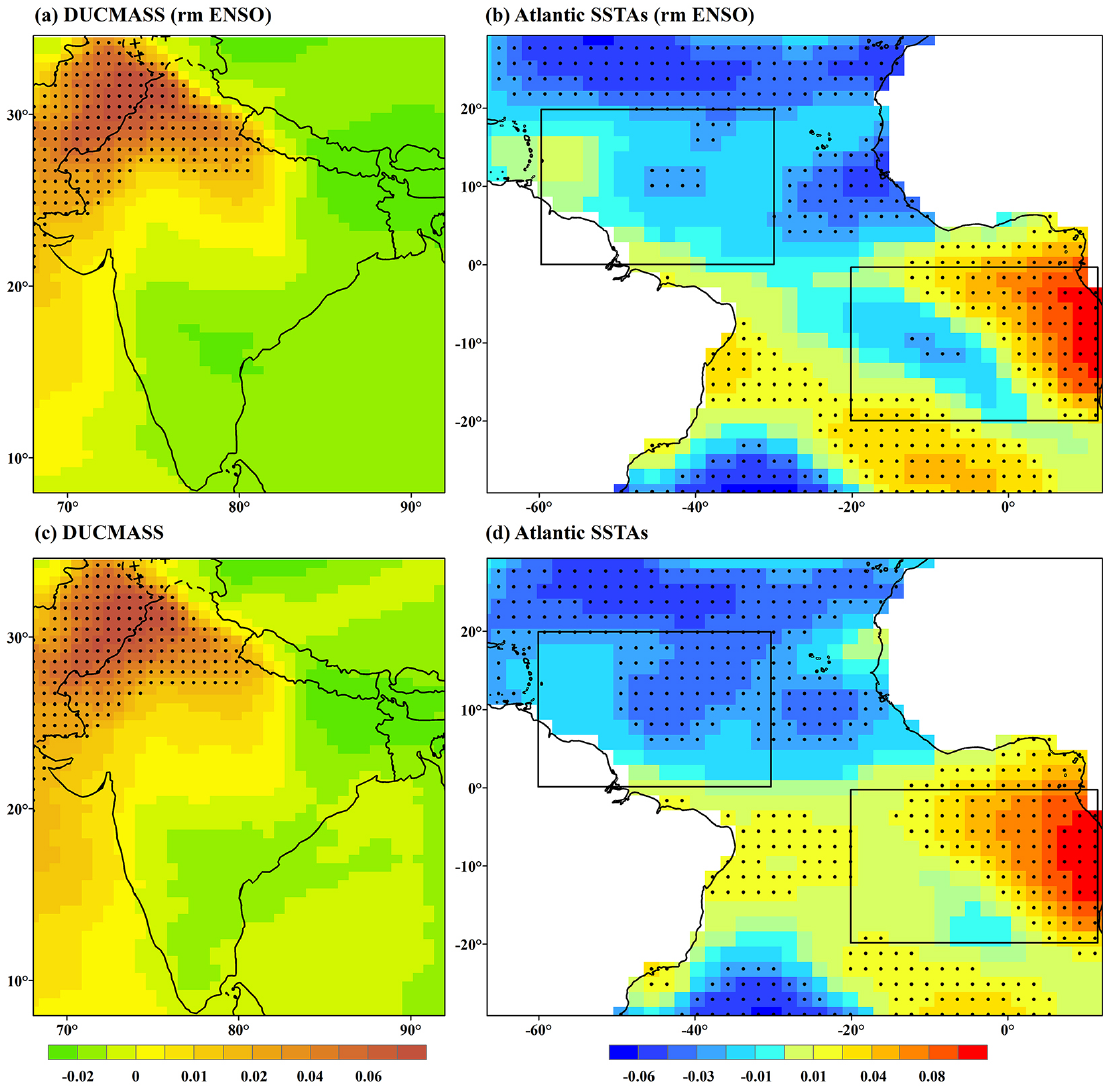
Figure 5. Spatial correlation between the spring (March–May) tropical Atlantic SSTA and DUCMASS of the first mode of the MCA analysis in 1982–2014. The first MCA mode of (a) the DUCMASS and (b) the tropical Atlantic SSTA with ENSO-related signals removed. (c–d) As in (a) – (b) but for the original series including the ENSO signal. The black dots represent significance at the ≥ 90% confidence